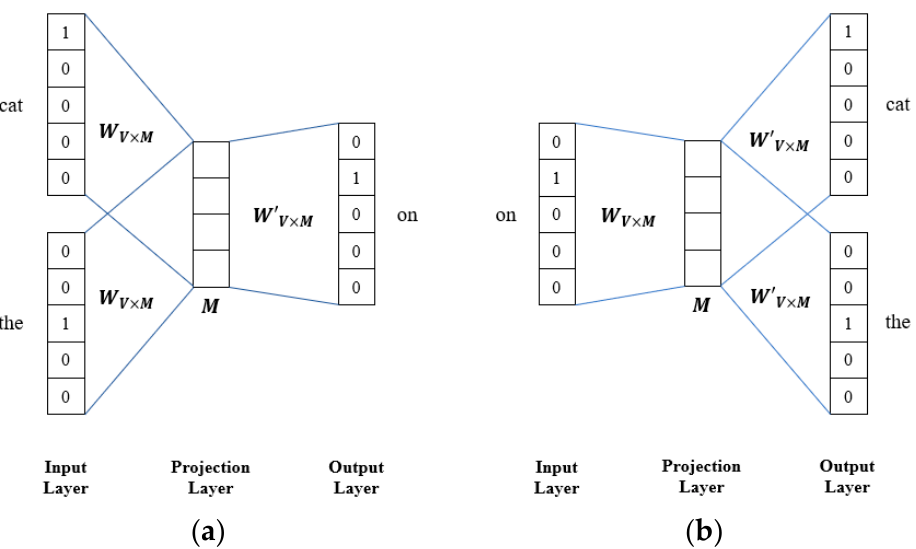
Figure 4. Architecture of Word2Vec. ( a ) CBOW model: It represents a vector of the central word through the surrounding words. ( b ) Skip-gram model: It represents a vector of surrounding words through the central word. Negative sampling is used to reduce computation that increases according to the vocabulary’s size.